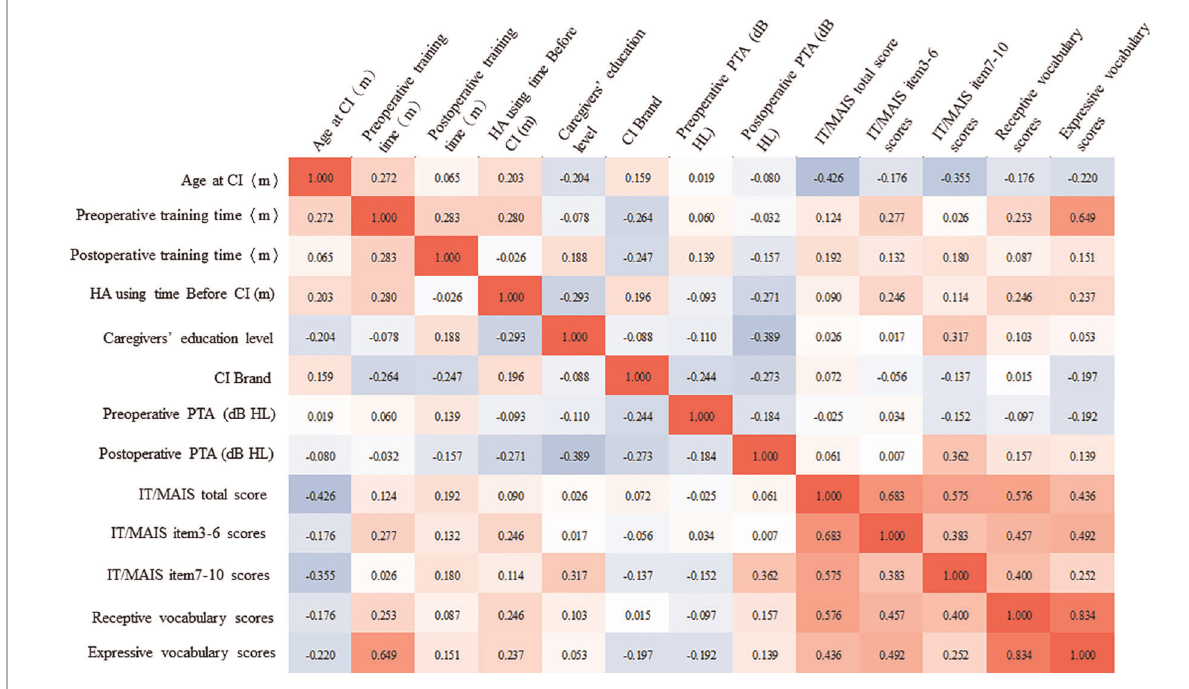
FIGURE 3 The correlational heat map shows between different predictive factors for children who received simultaneous bilateral CIs. The red fi lling represents the positive correlation, the blue fi lling represents the negative correlation, the depth of shade of the color represents the degree of correlation. Analyses were performed by the 2-tailed Spearman correlation